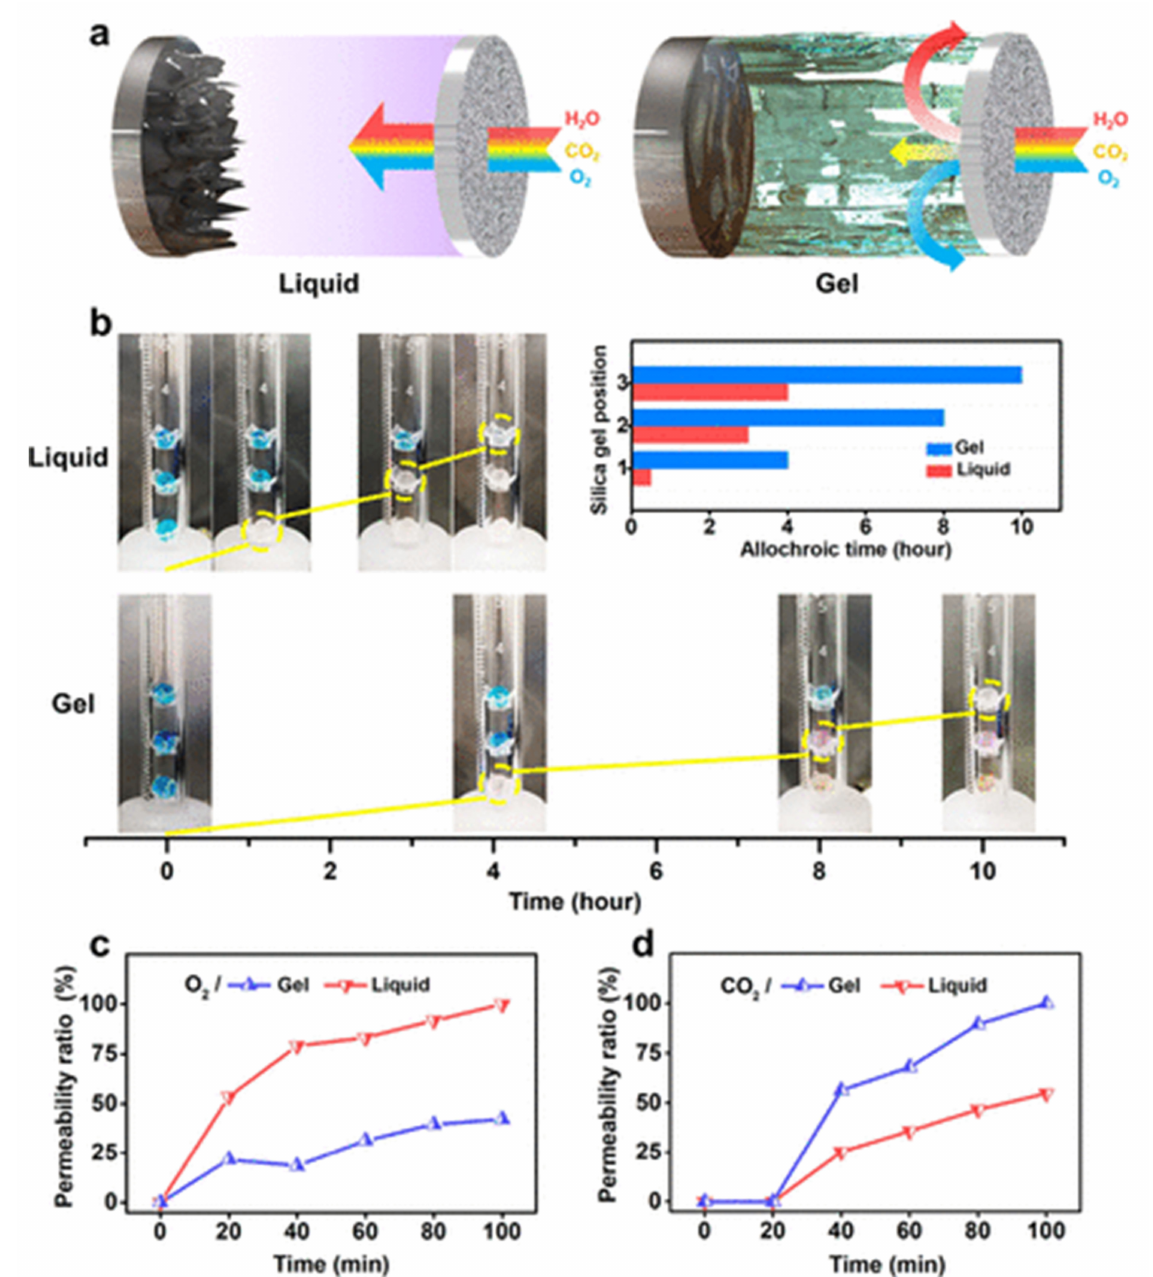
Figure 29. ( a ) Schematic representation of H 2 O and air permeability in gel and liquid electrolyte. ( b ) Snapshots of the anti-water vapor permeability test. ( c , d ) GC analysis of corresponding contents (adapted with permission from [374] ACS Cent. Sci.,